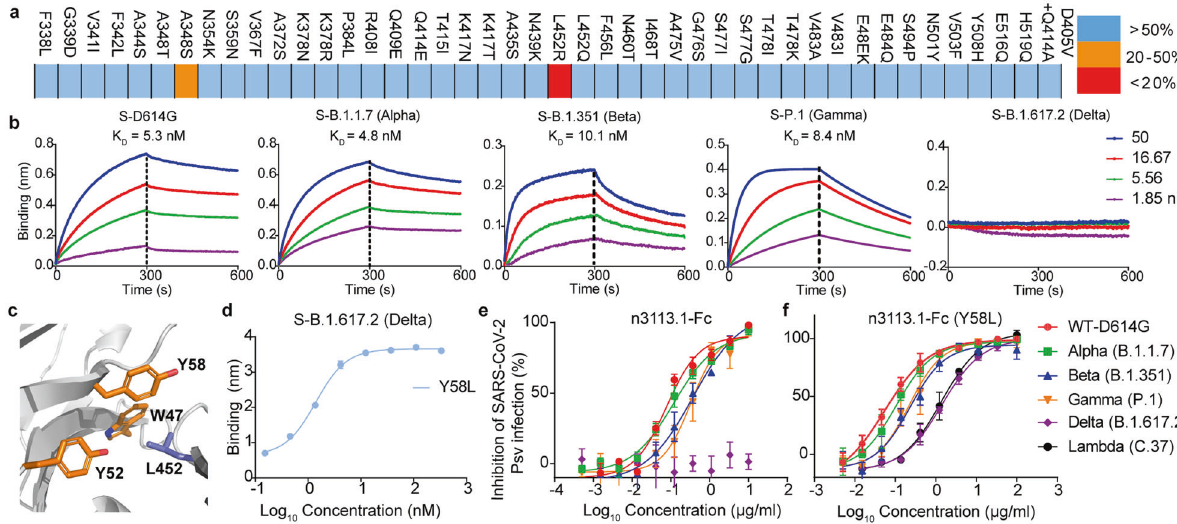
Fig. 4 N3113.1 (Y58L) maintains susceptivity to circulating SARS-CoV-2 variants. a Binding af fi nity of n3113.1 with RBD variants. Colors represent the extent of binding af fi nity percentage relative to wild-type RBD: blue, over 50%; orange, 20% to 50%; red, less than 20%. b Binding kinetics of n3113.1-Fc to spike variants, as measured by BLI. K D values for n3113.1-Fc were obtained using a 1:2 bivalent model. c Binding mode of RBD-L452 and n3113. RBD and n3113 are shown as cartoon, colored in blue and orange, respectively. RBD-L452 and residues on n3113 that form hydrophobic interactions are shown as sticks. d Binding of Y58L mutations based on n3113.1-Fc to S protein of Delta variant. The mean ± SD from two independent experiments is shown. e Neutralization pro fi les for n3113.1-Fc against viruses pseudotyped with the S protein of WT and four VOCs. Two independent experiments were performed in triplicate. f Neutralization pro fi le of n3113.1-Fc (Y58L) against viruses pseudotyped with the S protein of WT, four VOCs, and one VOI. The mean ± SD from three independent experiments is